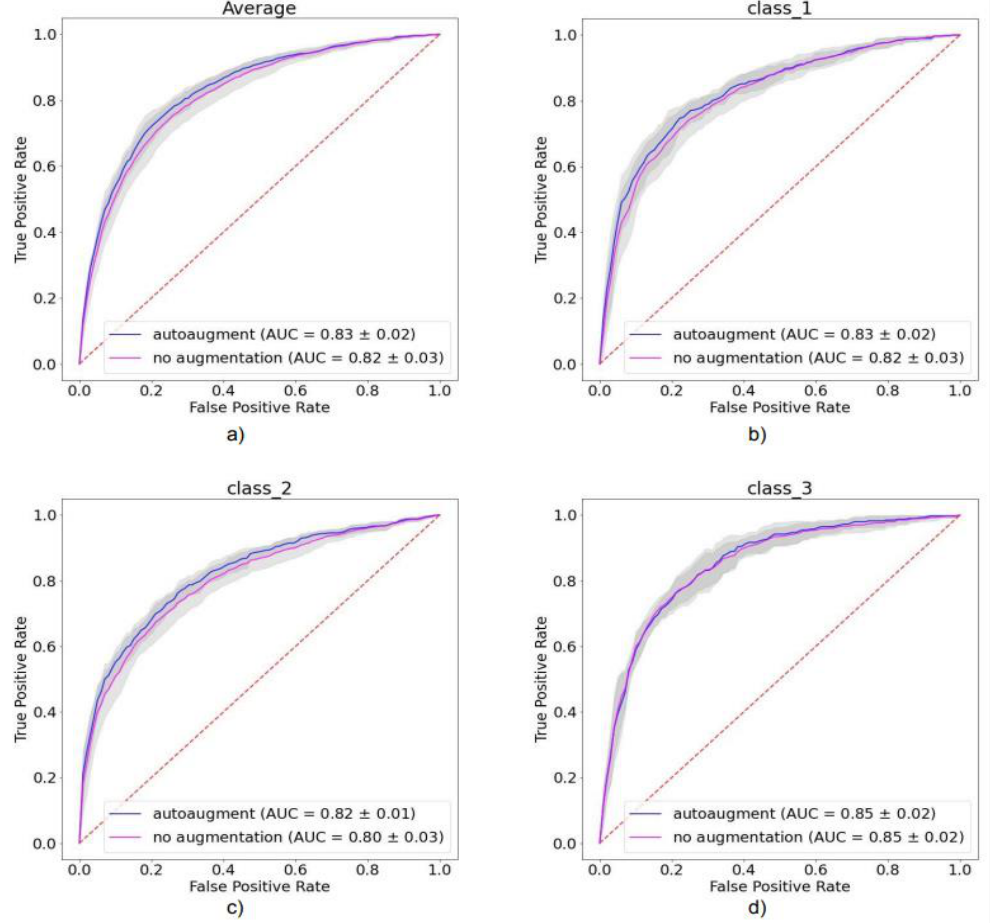
Figure 6. Average and class-wise receiver operating characteristic curves and area under the curve values for ( a ) average of all classes, ( b ) Angle class I, ( c ) Angle class II, and ( d ) Angle class III.